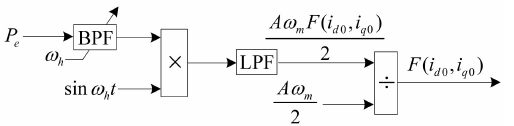
Figure 3. Demodulation technique for extracting the MTPA indicator